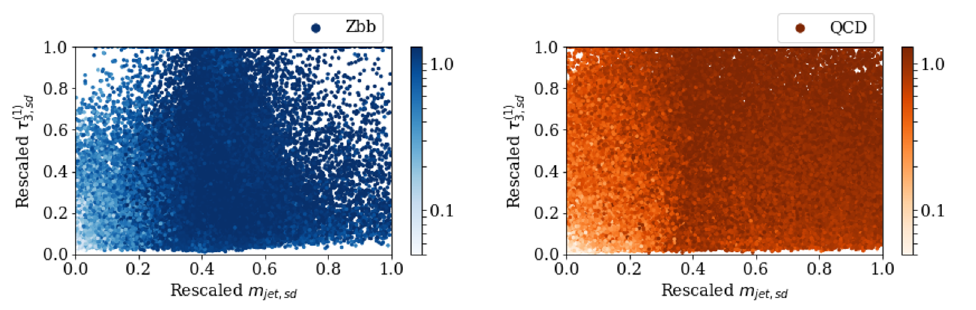
vs m jet , SD for 3 , SD